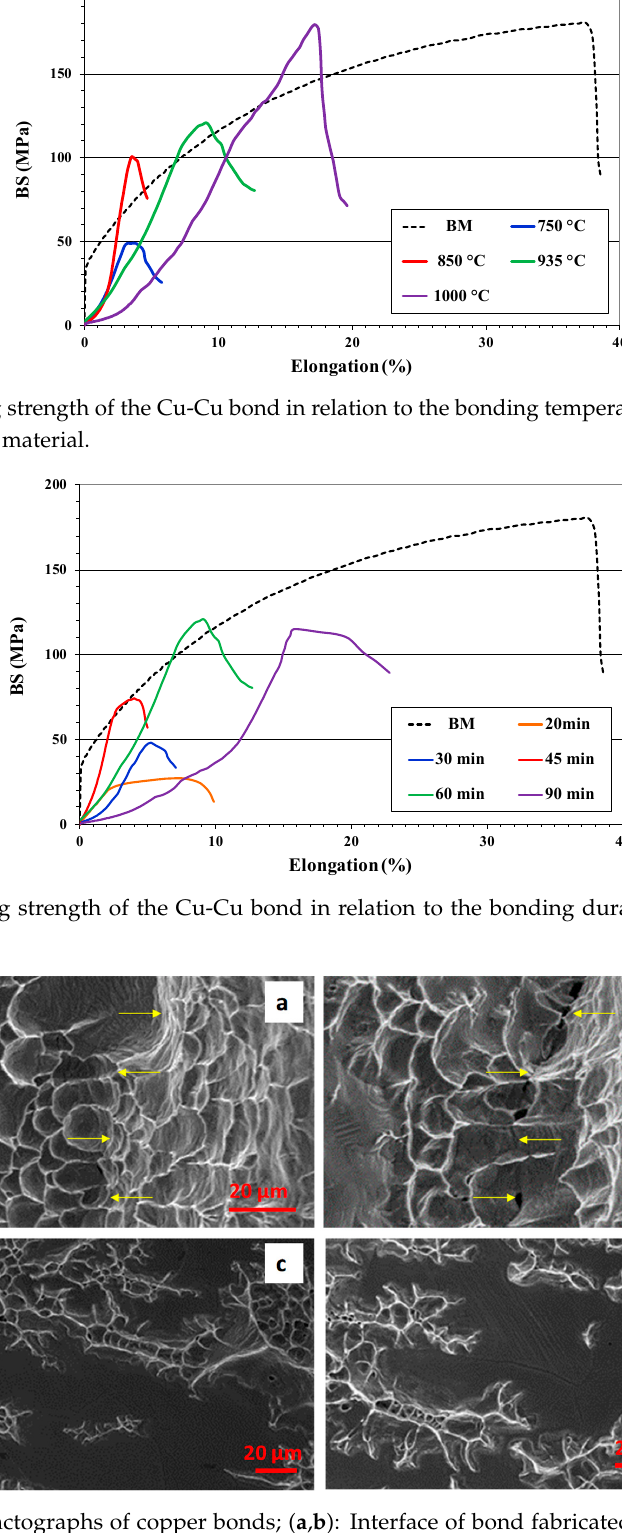
Figure 9. SEM fractographs of copper bonds; ( a , b ): Interface of bond fabricated at 1000 °C/90 min (the arrows show the interface orientation between the partially detached Cu plates), ( c , d ): fractured surfaces of Cu plates bonded at 750 °C/90 min.